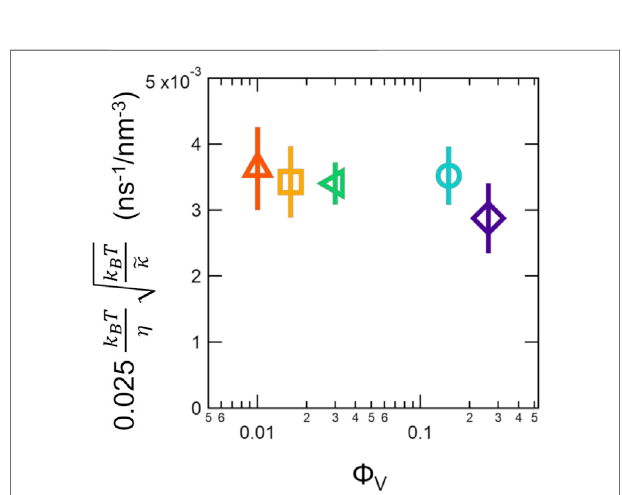
FIGURE 7 | Best fi t slopes to plots of Γ ZG versus q 3 , which is inversely proportional to the effective bending modulus ( ~ κ ) according to Eq. 16 as a function of the vesicle volume fraction. Error bars represent the 95% con fi dence intervals on the best fi t slopes of the respective plots of Γ ZG versus q 3